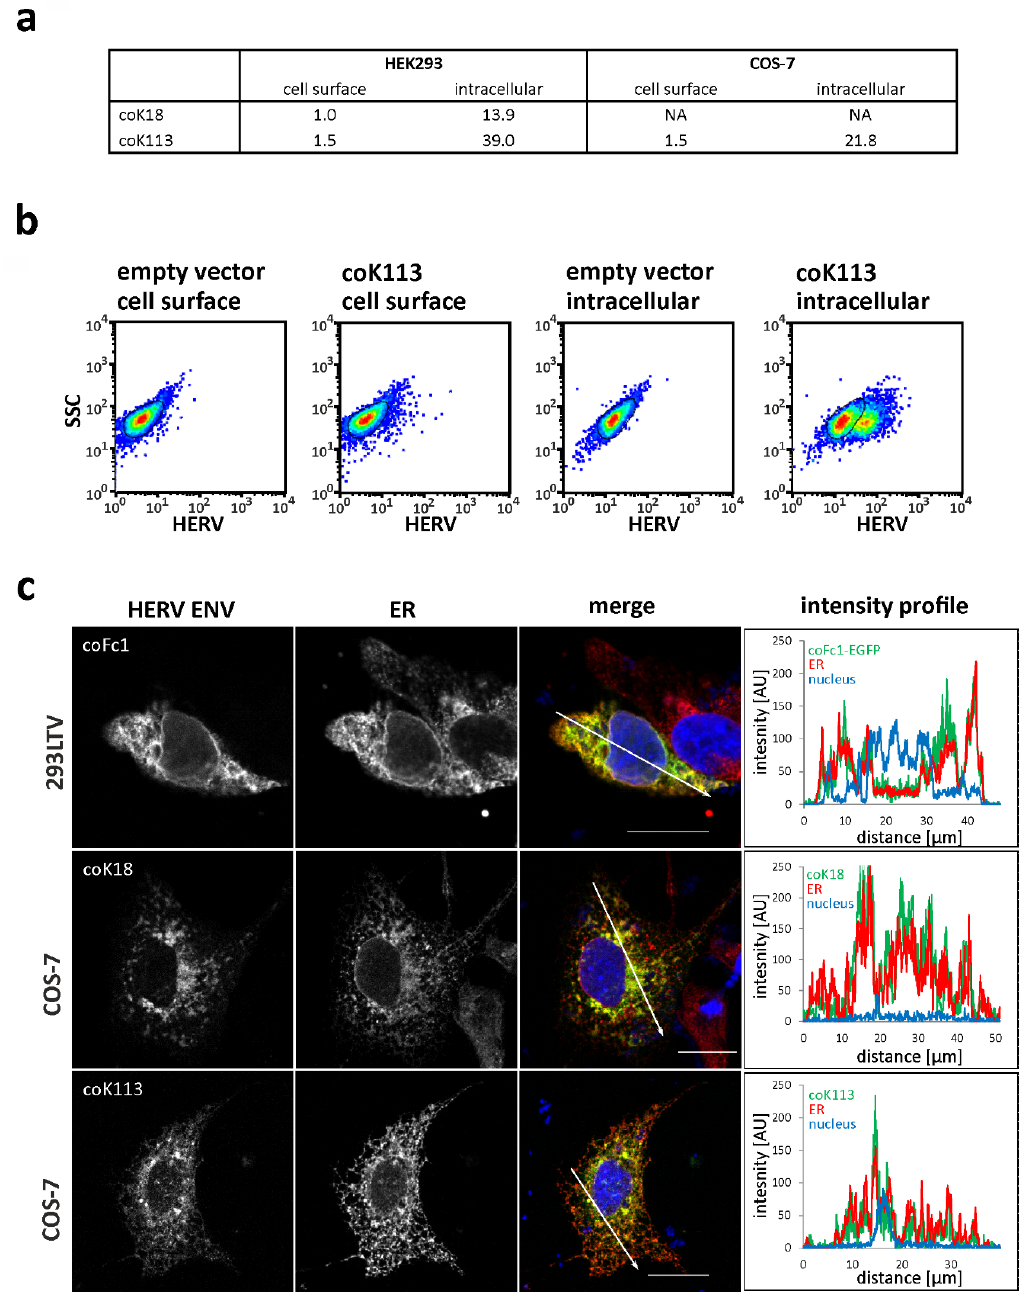
Figure 3. Localization of HERV ENV in transfected HEK293 cells, 293LTV cells, and COS-7 cells. ( a,b ) Flow cytometry of transiently transfected, non-permeabilized or permeabilized HEK293 cells and COS-7 cells stained for HERV-K ENV. The table in ( a ) shows the percentage of fluorescent cells. NA, not analyzed. In ( b ) the dot plots of HEK293 cells transiently transfected with coK113-FLAG and empty vector are shown. No staining without primary antibody was observed (Supplementary Figure S6). ( c ) Fluorescence microscopic images showing the subcellular localization of specified HERV ENV and the endoplasmic reticulum (ER) in transiently transfected COS-7 cells and 293LTV cells. The merge image is a z-projection (maximum intensity) of the three recorded channels (green: HERV ENV, red: ER, blue (DAPI): cell nucleus). Pixels with red and green fluorescence appear yellow. The graphs show a fluorescence intensity profile along the arrows drawn in the merge image. The detection of envelope proteins was performed using anti-HERV-K-TM antibody HERM1811-5 (coK18, coK113) or EGFP tag (coFc1). The ER was visualized by an anti-calnexin antibody. Scale: 20 µ